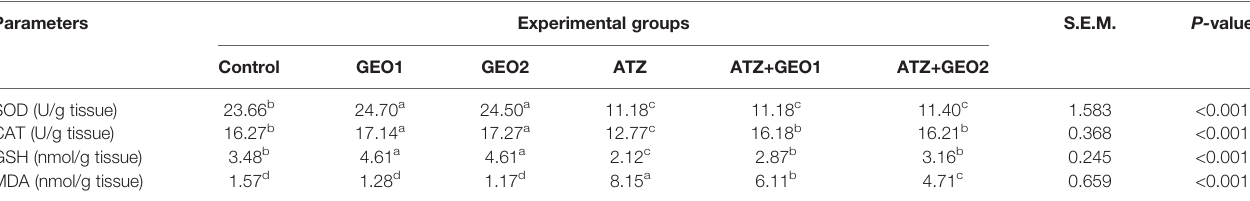
TABLE 4 | Hepatic oxidative status biomarkers of Nile tilapia in response to sub-lethal atrazine (ATZ) exposure and/or dietary supplementation with Panax ginseng essential oil (GEO) for 60 days.